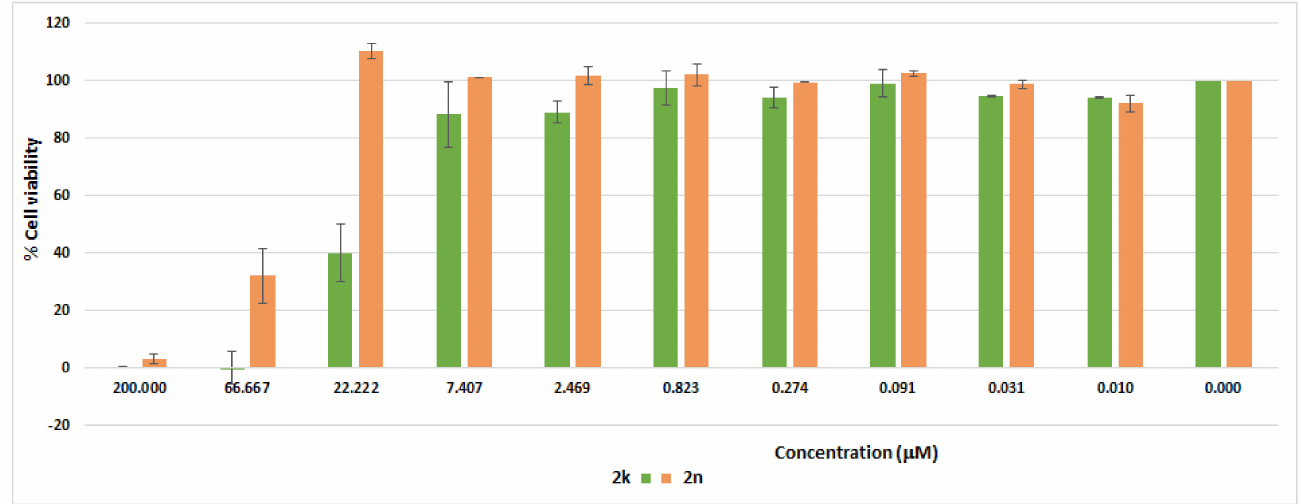
Figure 7. Cytotoxicity profile of compounds 2k and 2n over normal Vero cells. The cells were incubated with various concentrations of 2k and 2n for 24 h (0.01, 0.03, 0.09, 0.27, 0.82, 2.47, 7.41, 22.2, 66.7, and 200 µ M) and MTT assays were conducted. Data are expressed as the mean ± SD of duplicate